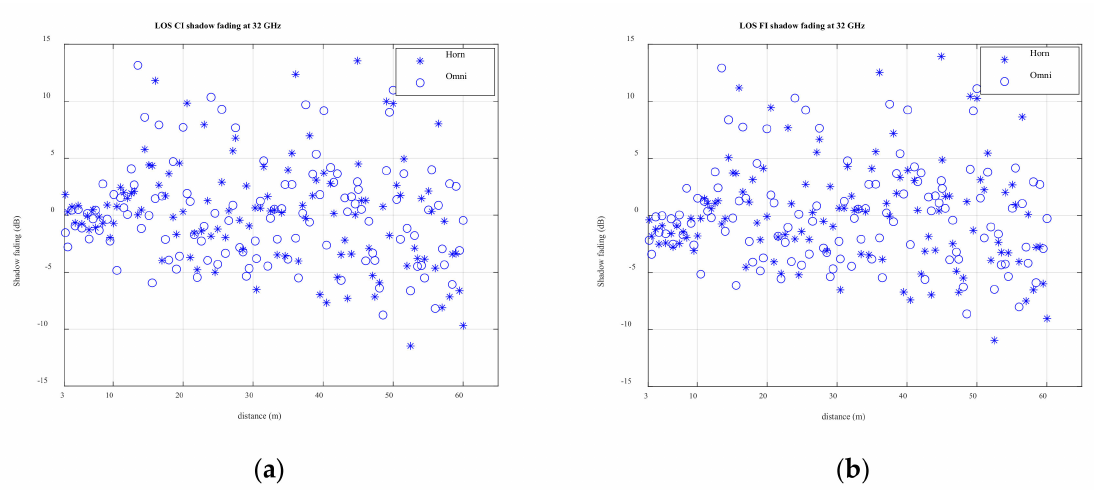
Figure 4. CI ( a ) an FI ( b ) shadow fading for the LOS path loss results at 32 GHz.